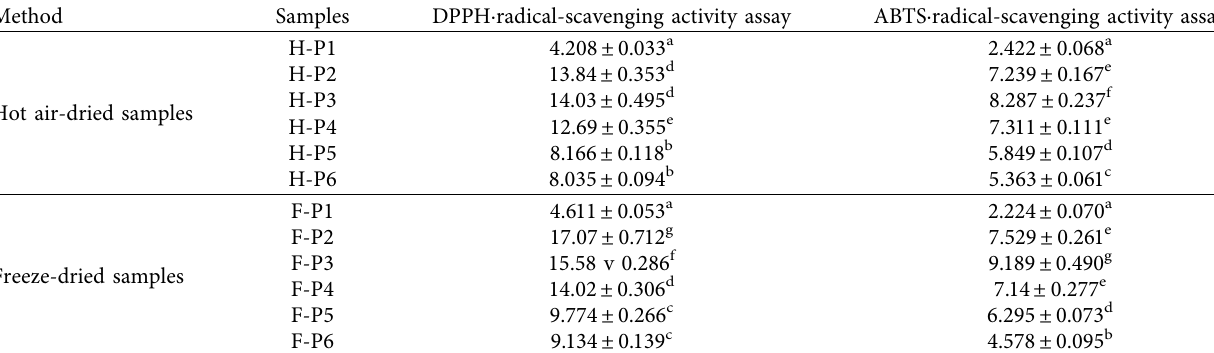
Figure 4: DPPH (a) and ABTS (b) free radical-scavenging potentials of CH 3 OH cabbage extracts. The mean and standard deviation are obtained from three independent experiments. Letters a–g indicate significant differences ( P < 0 . 05). P1, leaves part 1; P2, leaves part 2; P3, leaves part 3; P4, leaves part 4; P5, leaves part 5, P6, leaves part 6. Table 2: EC 50 (mg/mL) values obtained from various antioxidant assays of cabbage extracts.